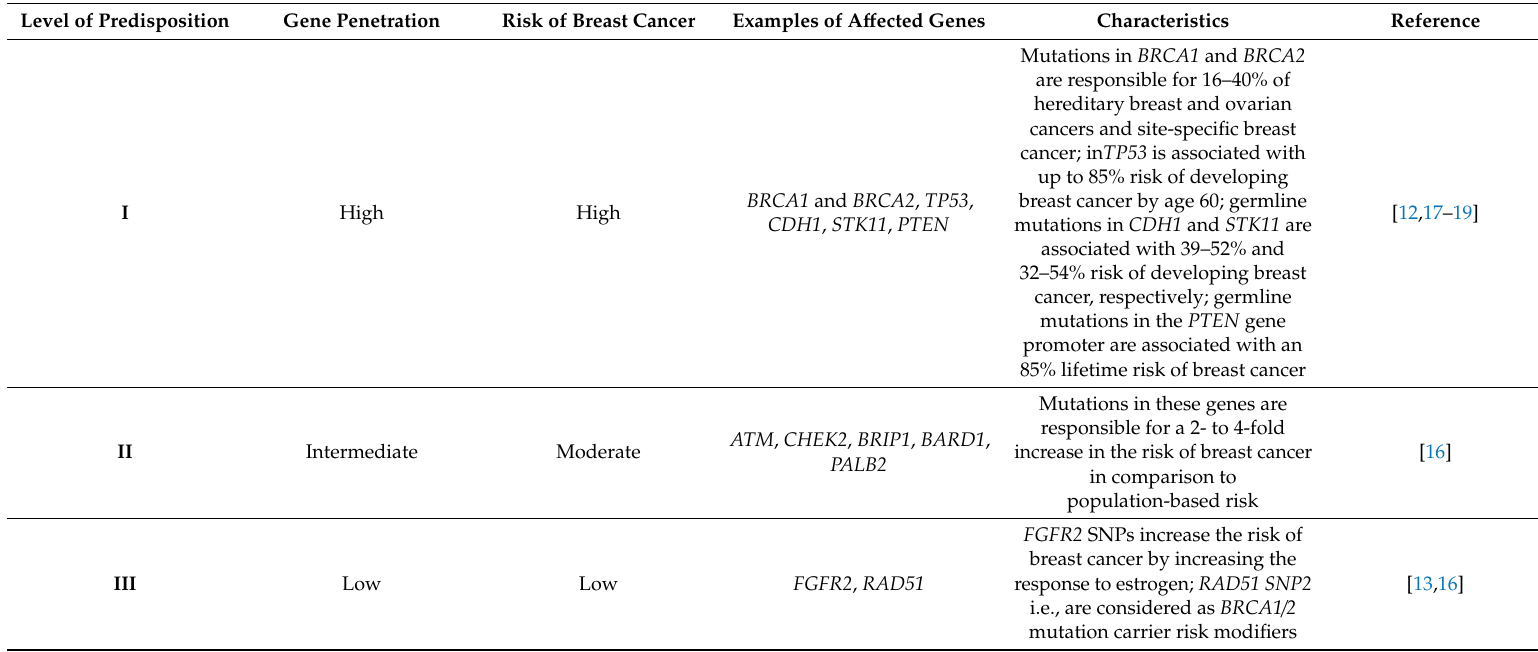
Table 1. Levels and characteristic of genetic predisposition to breast